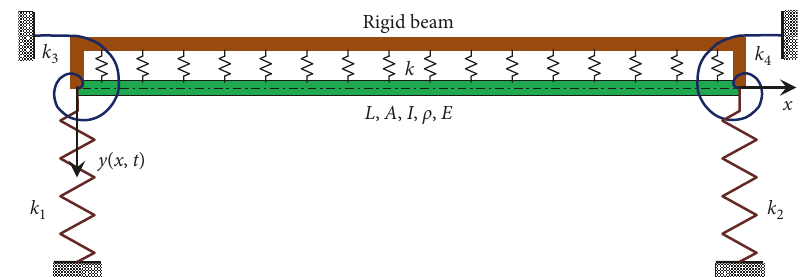
Figure 1: Elastically restrained Euler beam resting on a movable Winkler foundation.